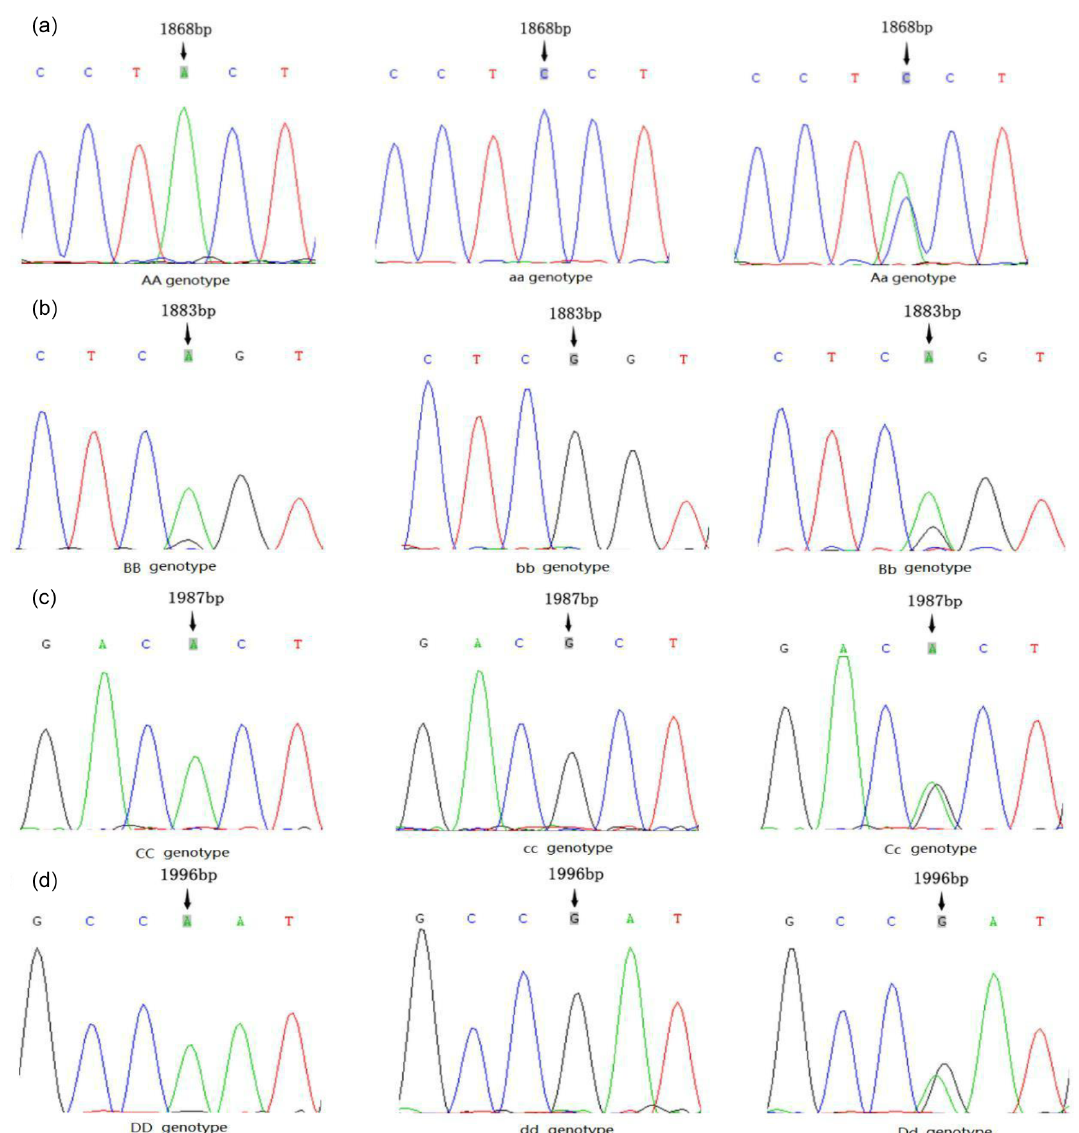
Figure 1. Genotype consisting of four mutation